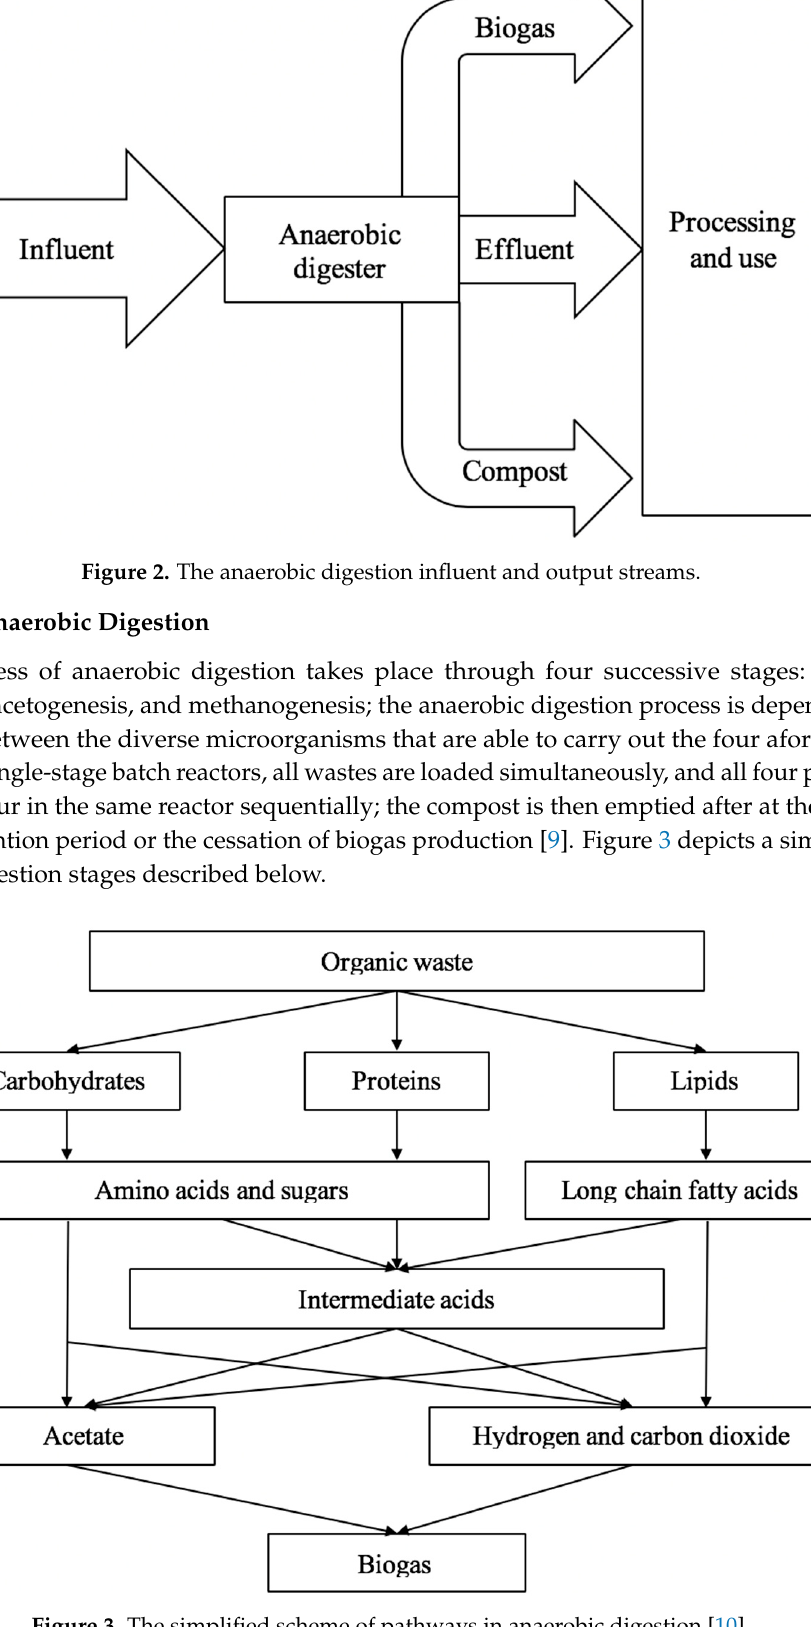
Figure 3. The simplified scheme of pathways in anaerobic digestion [10].